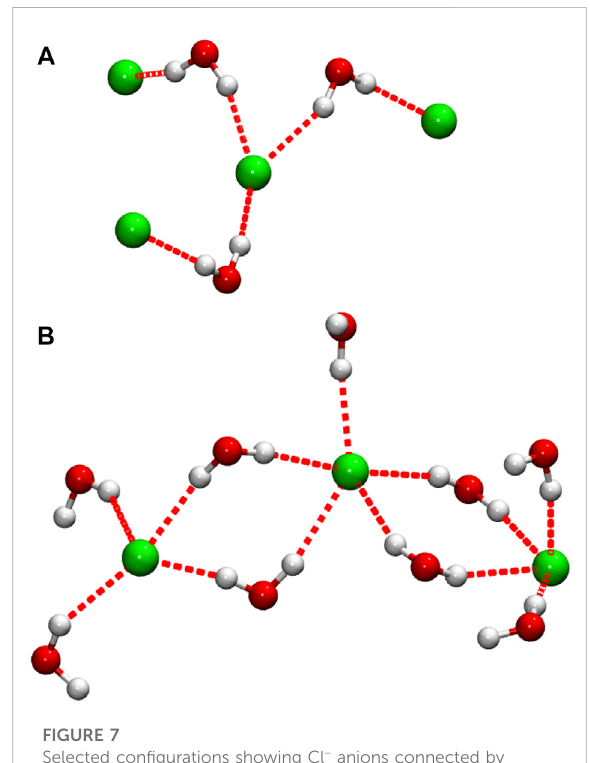
FIGURE 7 Selected con fi gurations showing Cl − anions connected by H-bonded water bridges. In the interest of clarity, only water molecules directly H-bonded (red dotted lines) to Cl − are shown. Con fi guration (A) was taken from the DES/water mixture at the lowest water content studied ( x W = 0.125), while (B) was taken from the highest water concentration ( x W = 0.875); con fi guration (B) forms part of a more expansive H-bonded